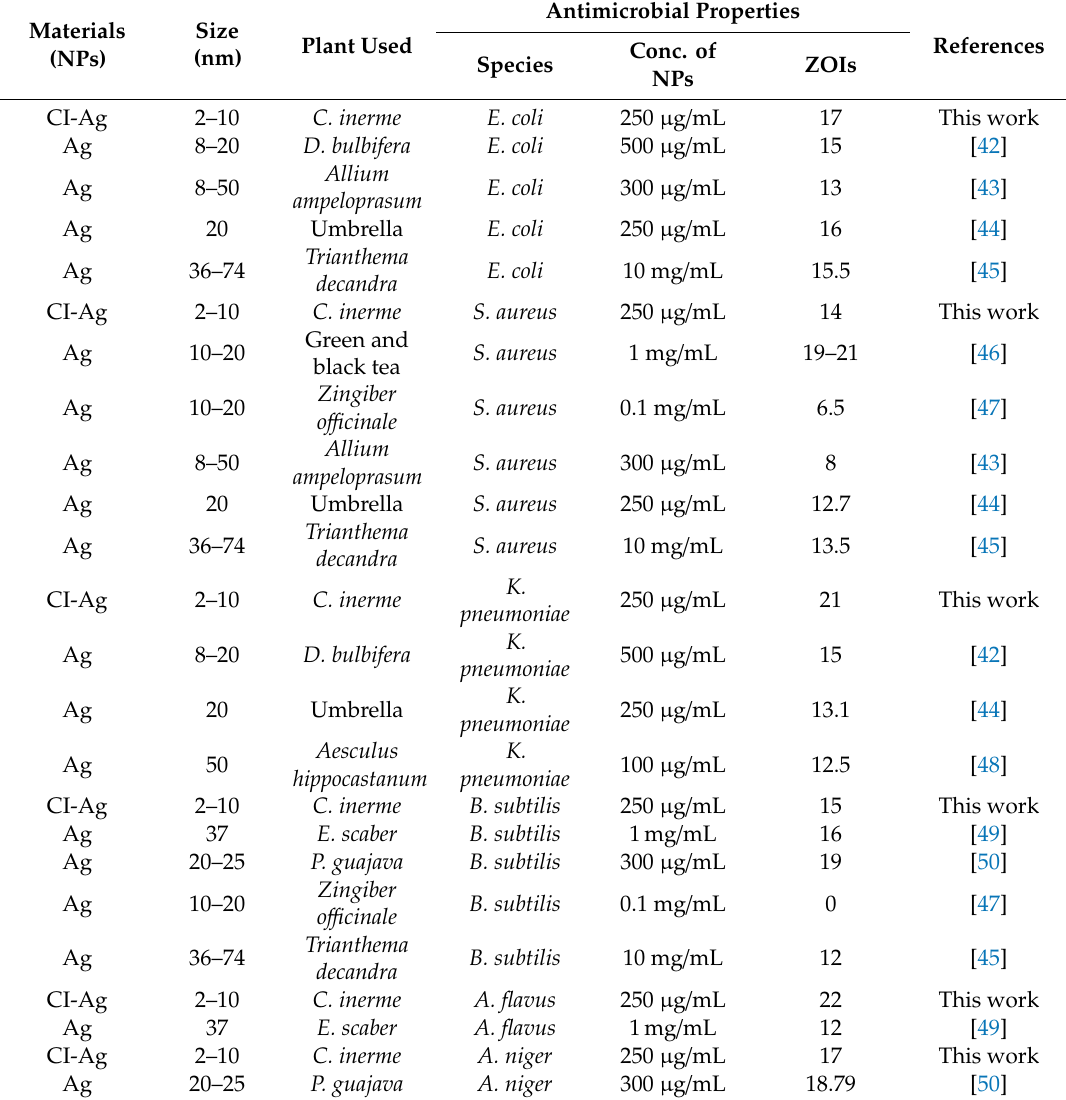
Table 1. Comparison of antimicrobial activities of green synthesized CI-Ag NPs with reported Ag NPs synthesized with other